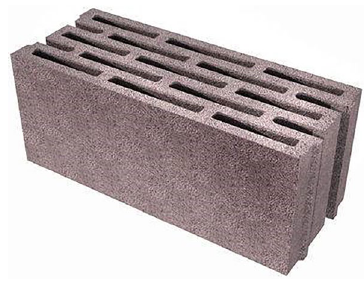
Fig. 2. Typical shape of masonry units made of lightweight